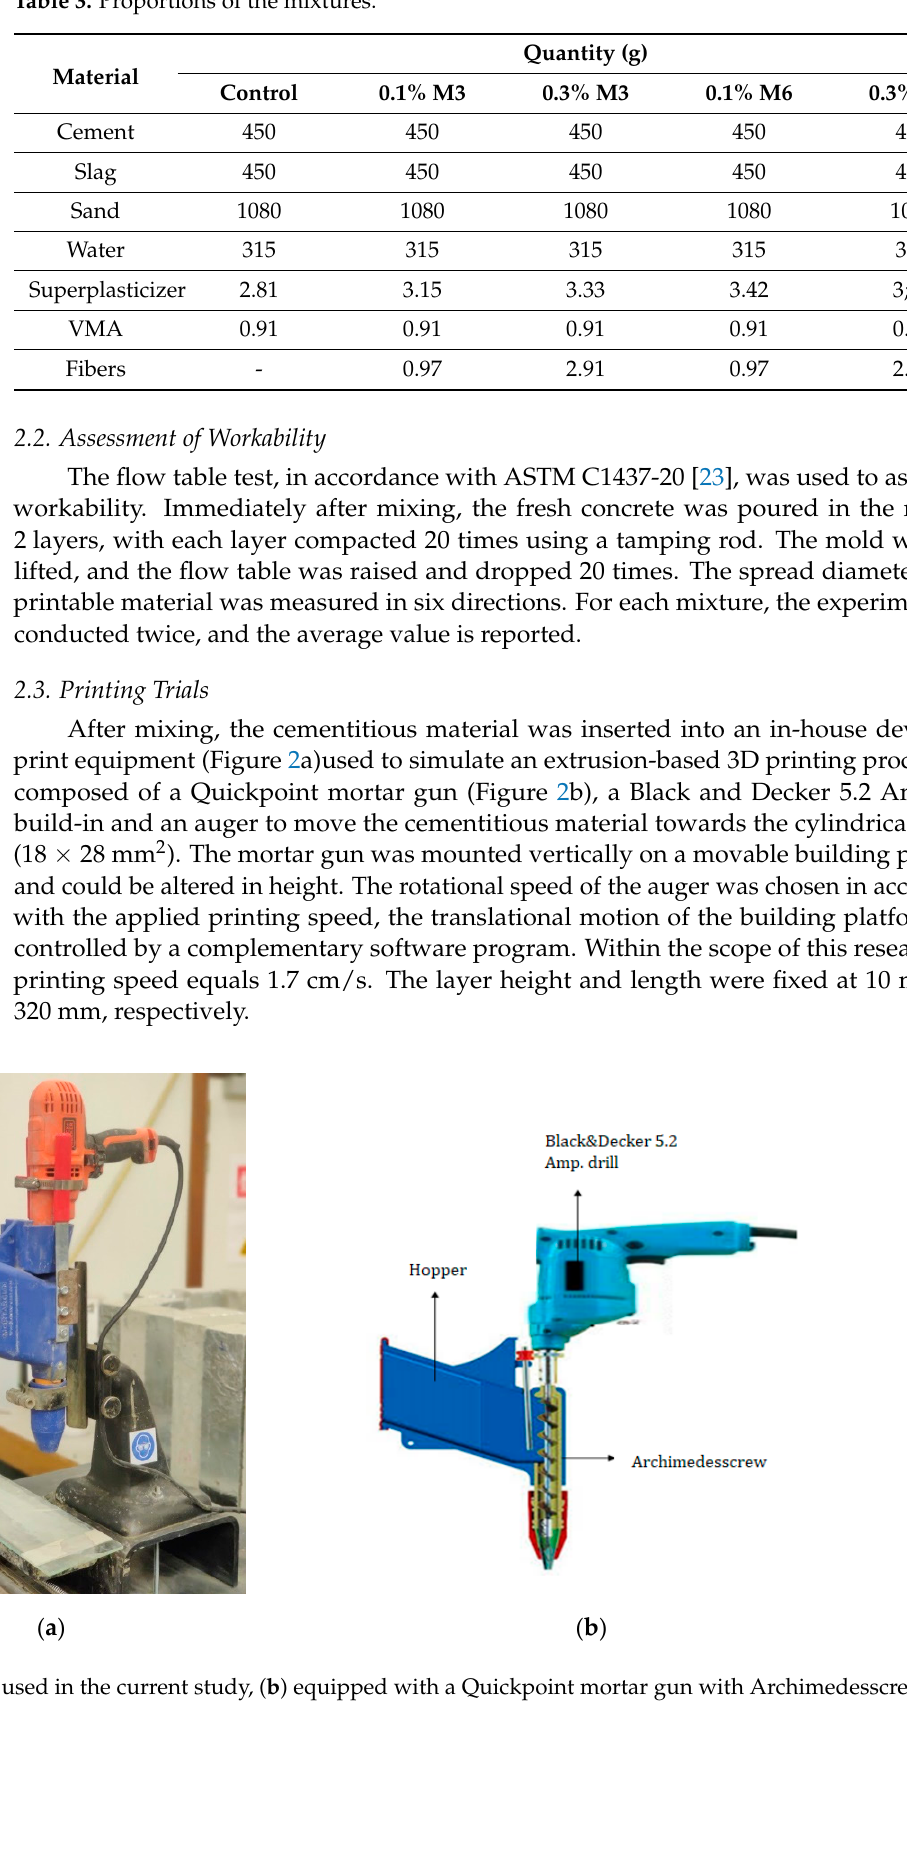
Table 3. Proportions of the mixtures.